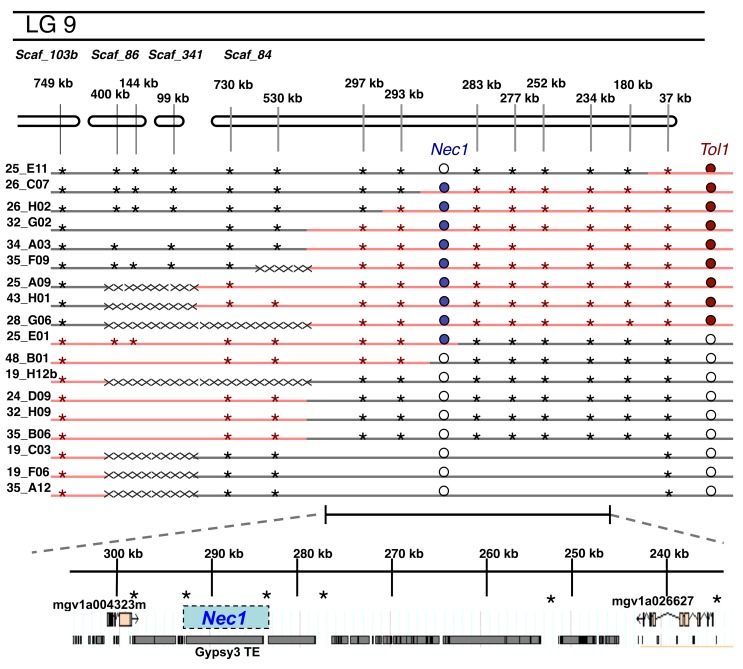
Genetic map of Nec1 region.Symbols are the same as described in Figure 2. Annotation of Nec1 region shows predicted structure of two genes flanking Nec1, mgv1a004323m and mgv1a026627. The repetitive elements in this region are shown as grey blocks below genes. Nec1 is almost entirely restricted to a Gypsy3 TE. Annotation based on M. guttatus Annotation v1.1, phytozome.net.